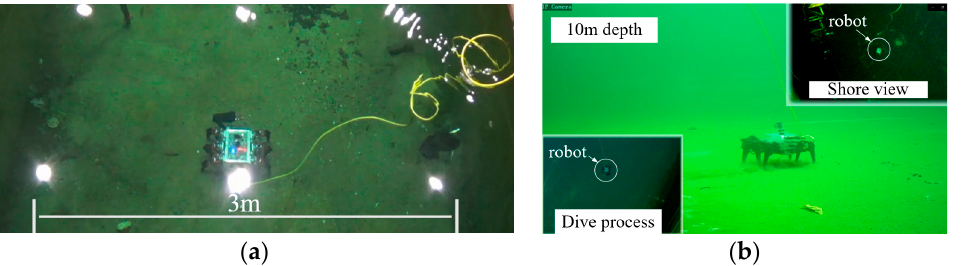
Figure 11. Underwater walking experiment. ( a ) is the speed experiment at a depth of 3 m, ( b ) is the depth experiment at a depth of 10 m.